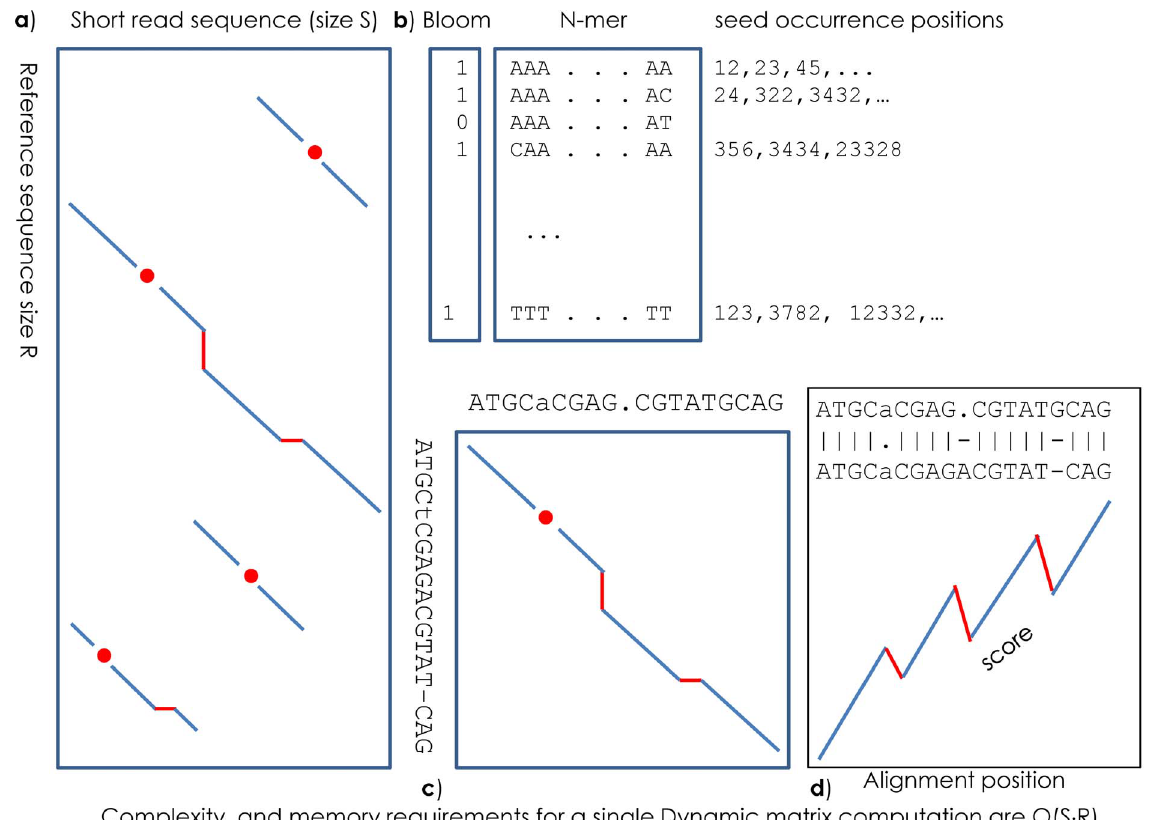
Figure 3. Optimal alignment search optimization schema. ( a ) Dynamic programming matrix Needleman-Wunsch or Smith-Waterman algorithms use a two dimensional rectangular matrix where cells represent the cumulative score of the alignment between short read (horizontal) and reference genome(vertical). ( b ) HIVE-hexagon maintains a bloom lookup table where each K-mer is represented only by a single bit signifying the presence or absence of that K-mer and 2-na hash table where a sequence’s binary numeric representation is used as an index. ( c , d ) The fuzzy extension algorithm allows accurate definition of the alignment frame and squeezes the window where the high scoring alignments might be discovered.